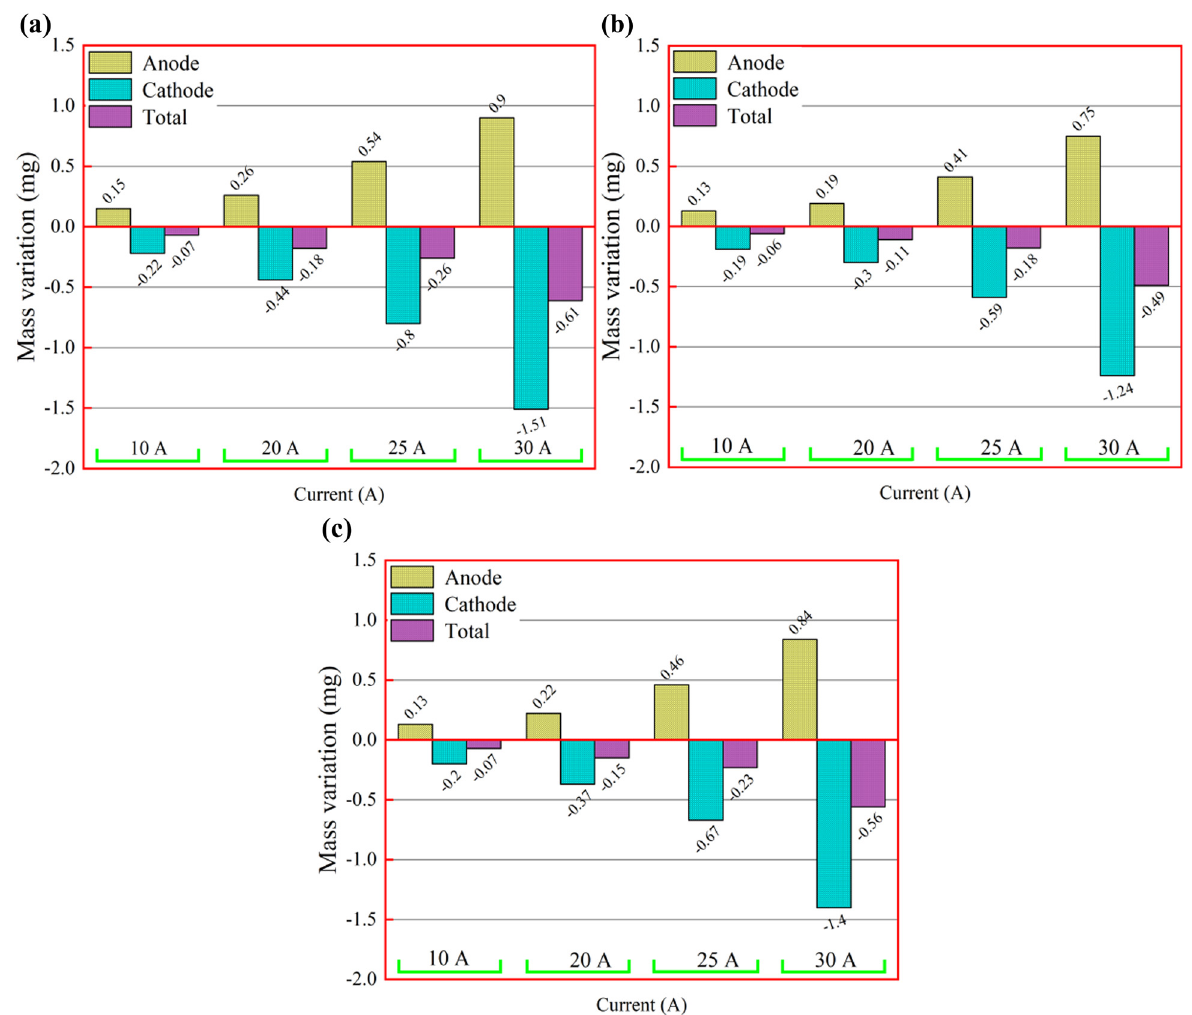
Figure 9: ( a ) Mass change of the Cu30Cr10W composite, ( b ) mass change of the 0.5GO/0.5CeO 2 – Cu30Cr10W composite, and ( c ) mass change of the 1.0GO/0.5CeO 2 – Cu30Cr10W